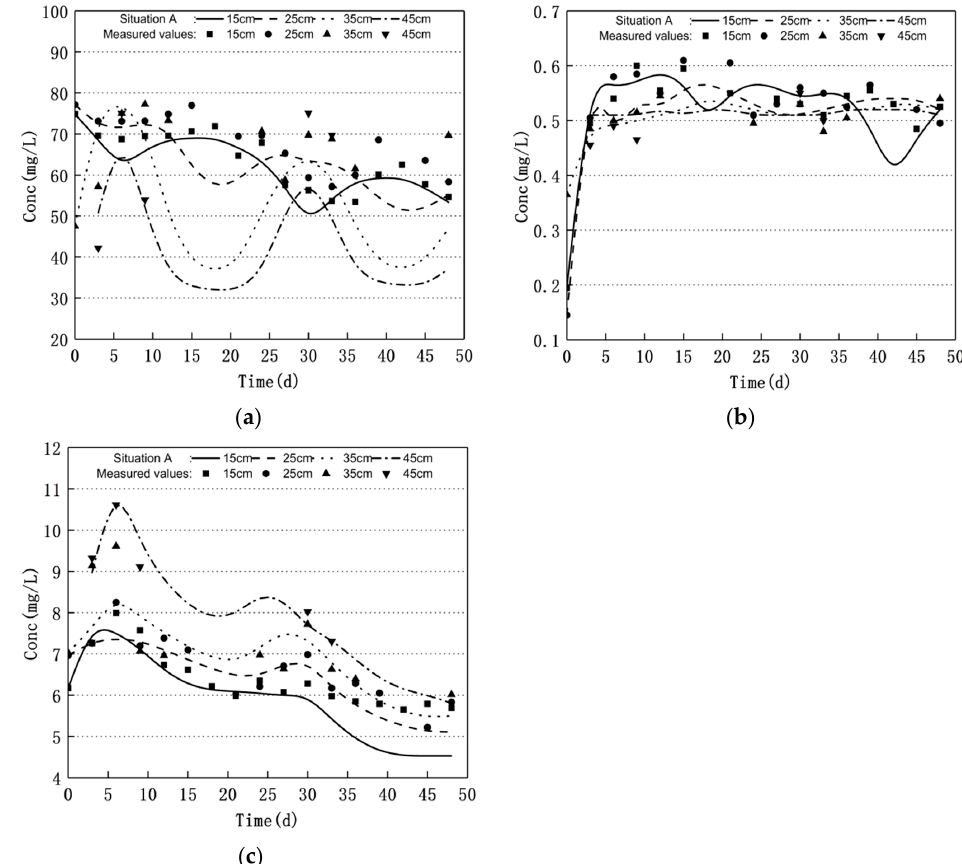
Figure 8. The measured results of coarse sand and the process of dynamic change of nitrogen in situation A (( a ) nitrate nitrogen; ( b ) nitrite nitrogen; ( c ) ammonium nitrogen).